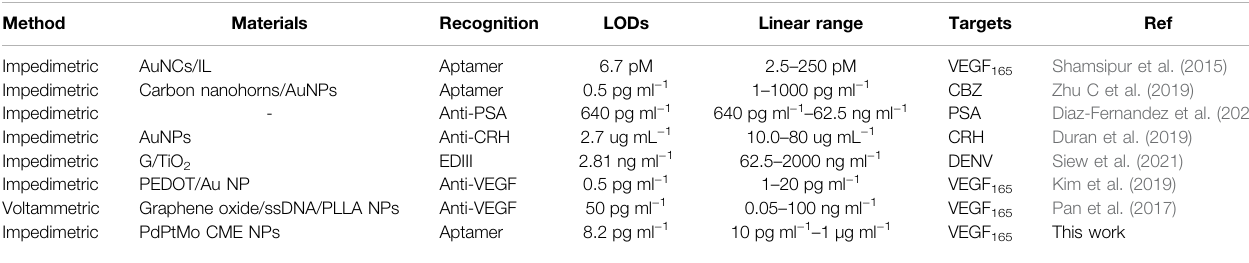
TABLE 1 | Comparison of the electrochemical